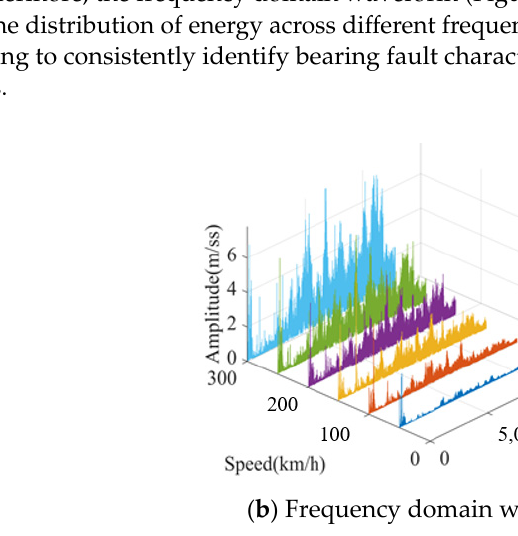
Figure 2. Time domain and frequency domain waveforms of wheelset bearings at different speeds.